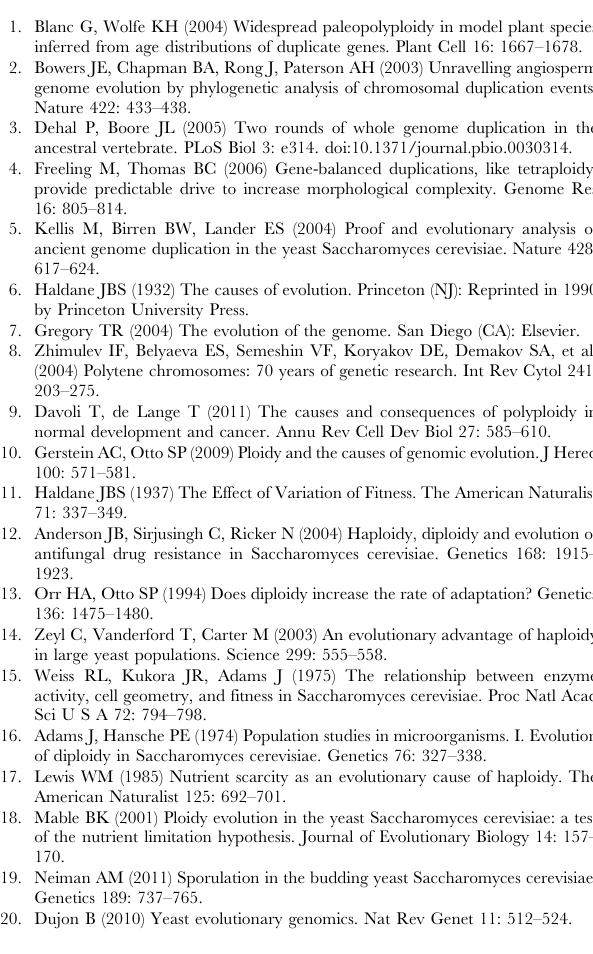
Table S3 Gene deletion strains used to screen for cell size effects on mitotic performance. Single gene deletions in the BY4741 (haploid) or, as homozygotes or heterozygotes, in the BY4743 (diploid) background used to screen for effects of cell size on mitotic performance in different environmental contexts (see Table S4). Table S4 Environments tested in cell size and mating type locus